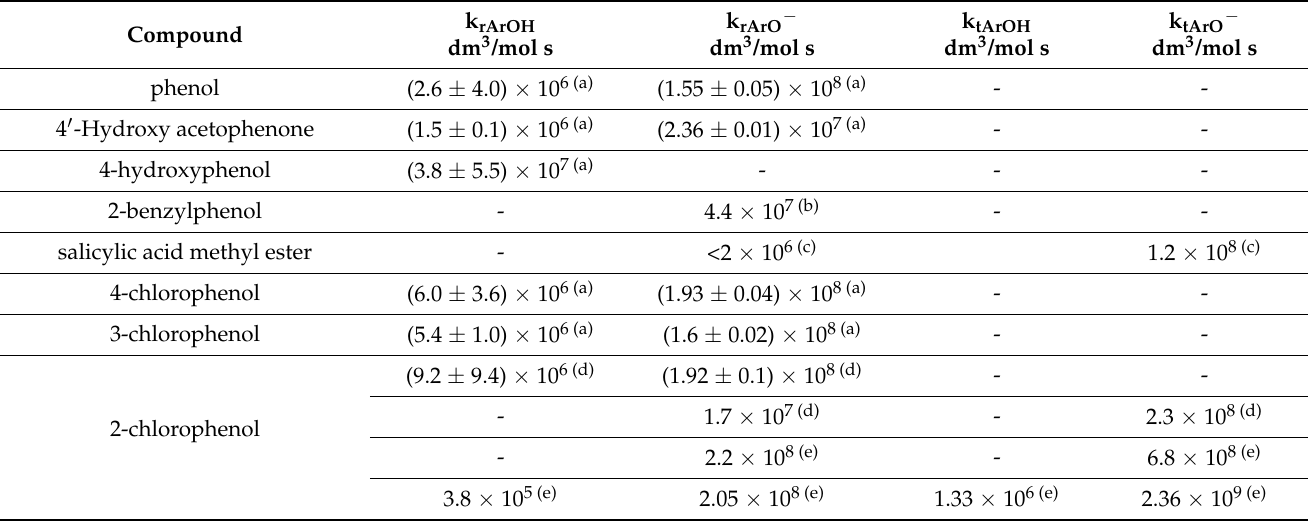
Table 6. Kinetic constants for singlet oxygen with similar structure MP available in the literature (k rArOH /k tArOH —undissociated form, k rArO − /k tArO − —dissociated